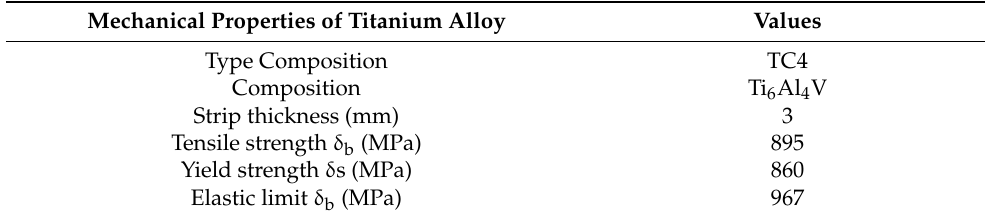
Table 1. Mechanical properties of titanium alloy at room temperature.